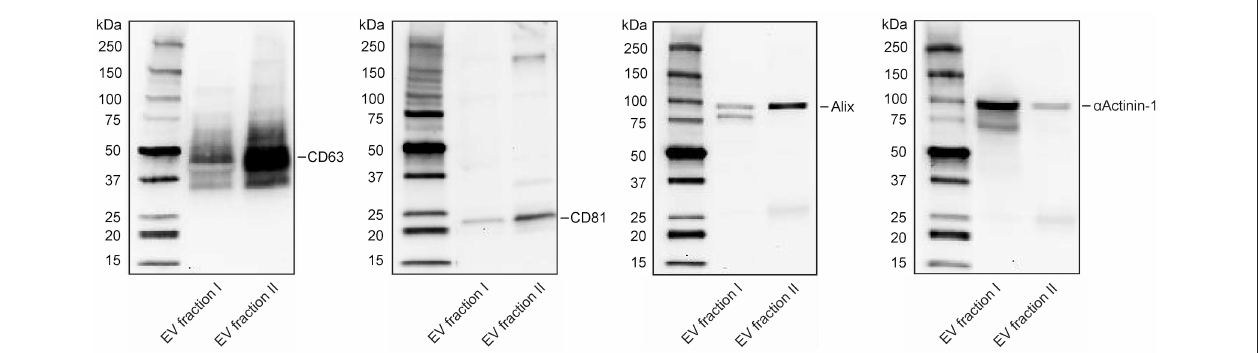
FIGURE 3 | Characterization of extracellular vesicle fractions by Western Blotting. Detection of CD63, CD81, Alix, and α Actinin-1 in EV fraction I (enriched in microvesicles) and EV fraction II (enriched in exosomes). Twenty microgram protein were loaded per lane. Exposure time: 5min for CD63, 11min for CD81, 10min for Alix, and 4min for α Actinin-1. Expected bands: 30–60, 22–26, 96, 100 kDa,